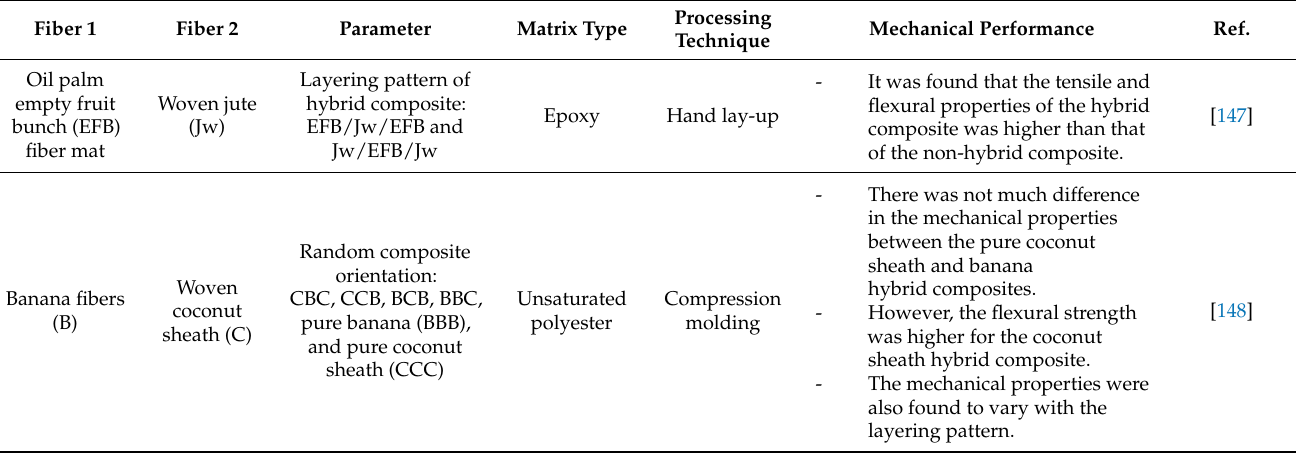
Figure 9. SEM images of hybrid composites: ( a ) fiber fracture, ( b ) fiber pull-out, ( c ) adhesion at the fiber–matrix interface. Reproduced from ref. [146]. Table 4. Studies on hybrid natural fiber/natural fiber-reinforced polymer